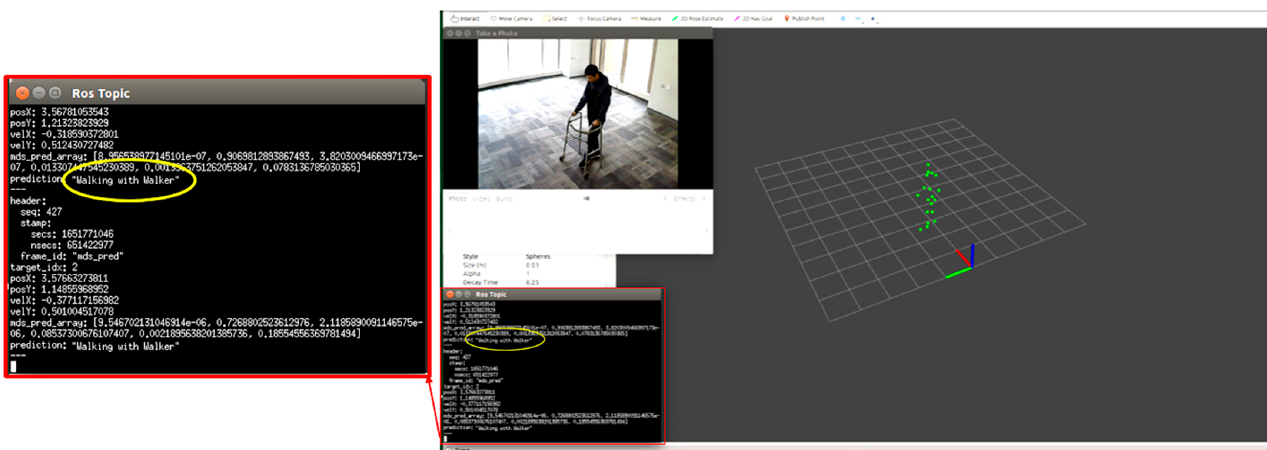
Figure 16. Subject walking with a walker.